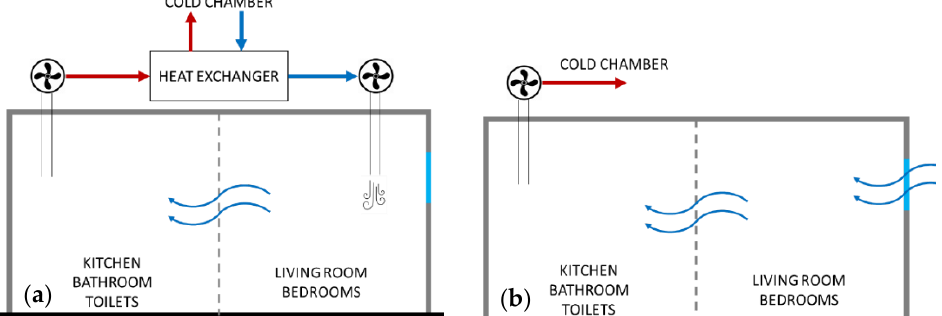
Figure 5. Ventilation network for the two ventilation systems — ( a ) dual air flow system, ( b ) single air flow system